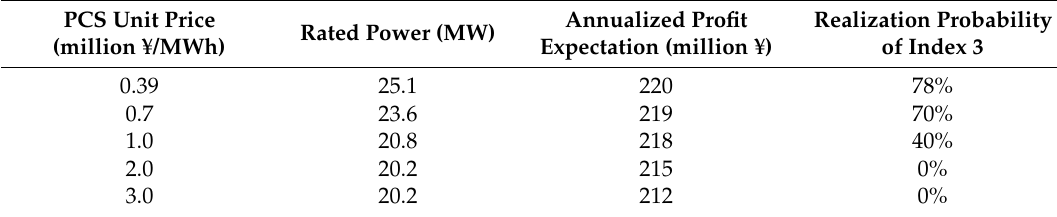
Table 4. Effect of PCS unit price on its rated power and the index of annualized profit.